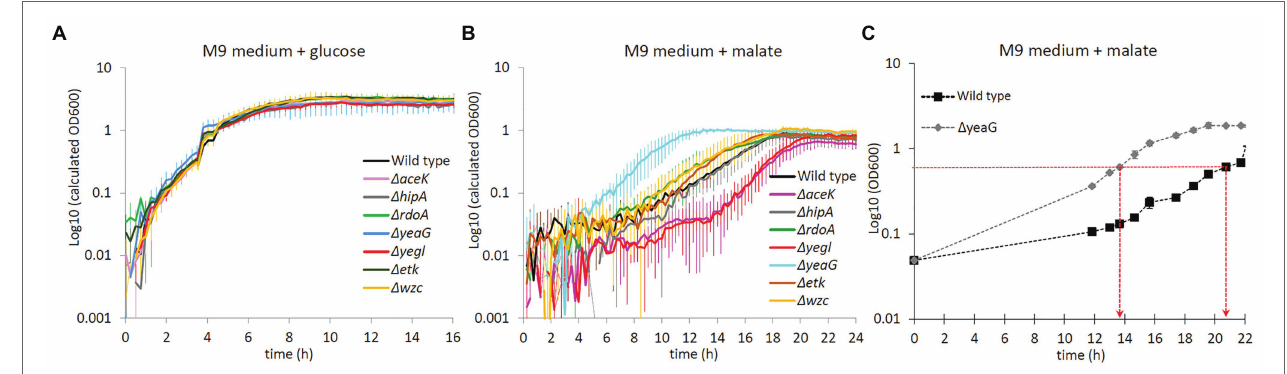
FIGURE 1 | Growth phenotype of Δ yeaG during glucose to malate shift. (A) Growth profiler experiment for different Escherichia coli strains (names indicated in the figure inset) shifted from M9 medium supplemented with glucose to fresh M9 medium supplemented with glucose: control with no metabolic shift (average of biological triplicates). (B) Growth profiler experiment for different E. coli strains (names indicated in the figure inset) shifted from M9 medium supplemented with glucose to fresh M9 medium supplemented with malate: metabolic shift from glucose to malate (average of biological triplicates). (C) Growth profile of Δ yeaG and wild type strains in batch cultures scaled up for the stable isotope labeling by amino acids in cell culture (SILAC) proteomics experiment (average of biological duplicates). Time points when samples were collected for the MS proteomics analysis (at OD 600 = 0.6) are indicated with red